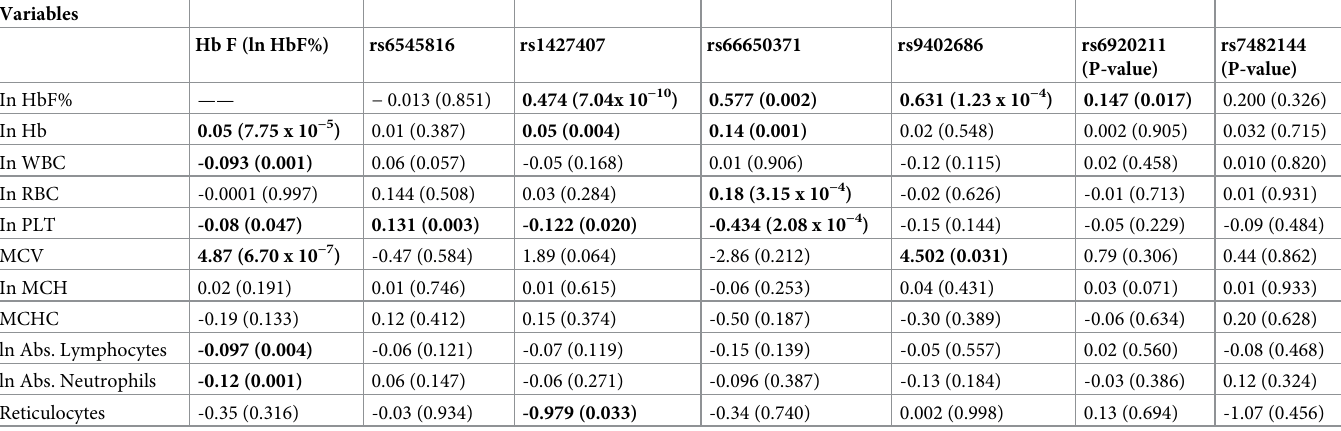
Linear multiple regression included sex and age as covariates. Allelic effects are presented as regression coefficient ( β , p-values in brackets). Bold font indicates statistical